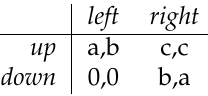
Figure 6. Battle of sexes with mixed strategy equilibrium ( a > b